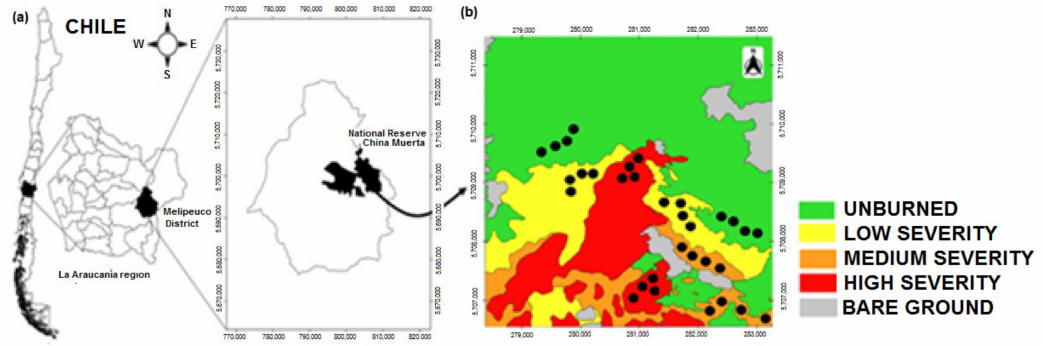
Figure 1. Map of the study site in the Andes ranges of southern Chile ( a ), including the burn severity conditions where arthropods were sampled ( b ). Black dots indicate pitfall traps set in triangular